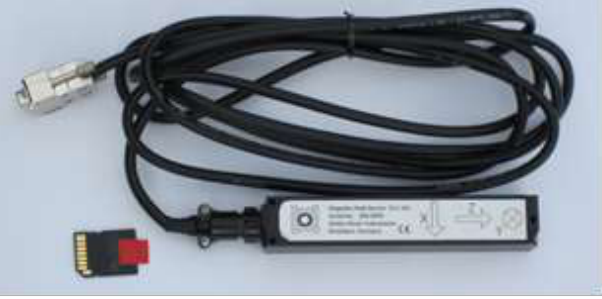
Figure 4. Triple axis fluxgate magnetometer and micro SD